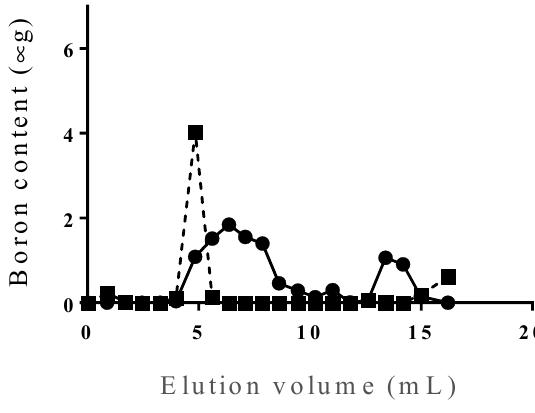
Figure A1. Incorporation of PBL to liposome.